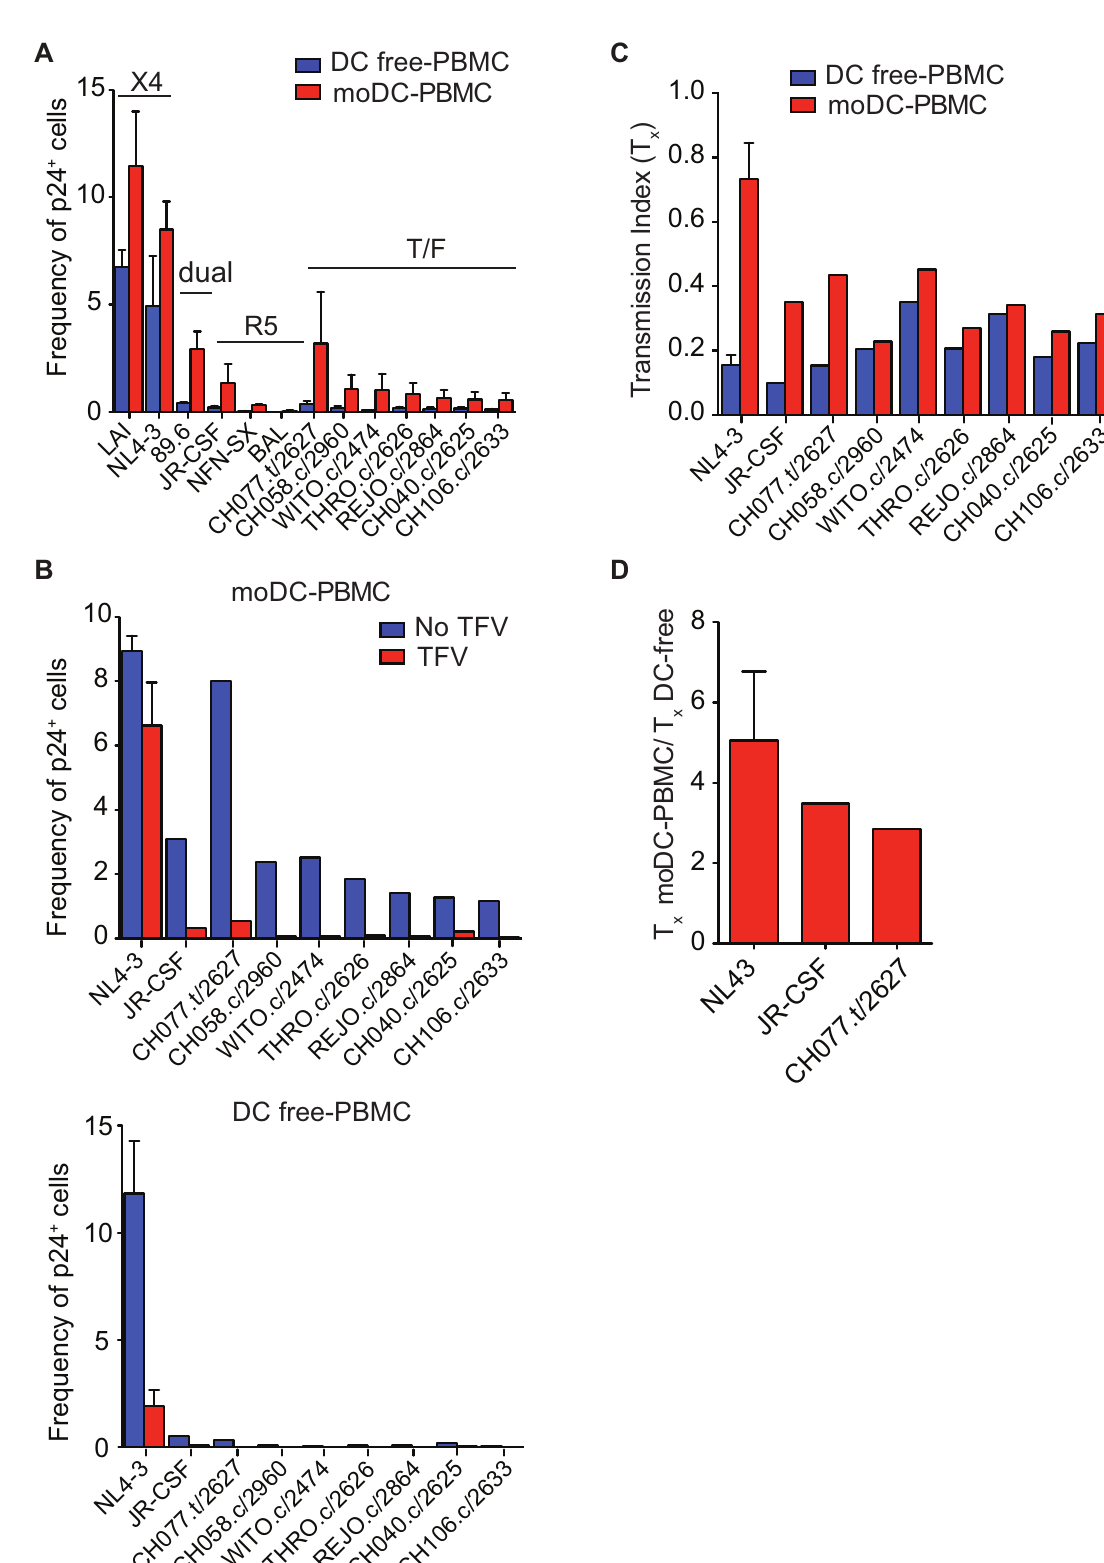
Fig 6. DC amplification of T cell infection with different HIV-1 isolates. ( A ) Infection of PBMCs with or without moDCs by CXCR4-tropic, dual-tropic, CCR5-tropic and T/F isolates, which were normalized to similar amounts of p24, were analyzed by flow cytometry. Frequency of p24 + T cells was measured by flow cytometry. ( B, C ) PBMCs with or without moDCs were infected with